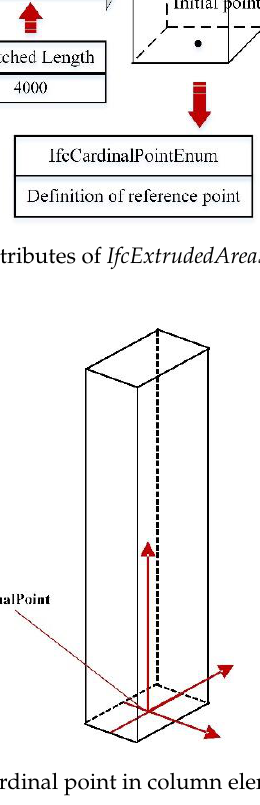
Figure 8. Attributes of IfcExtrudedAreaSolid.